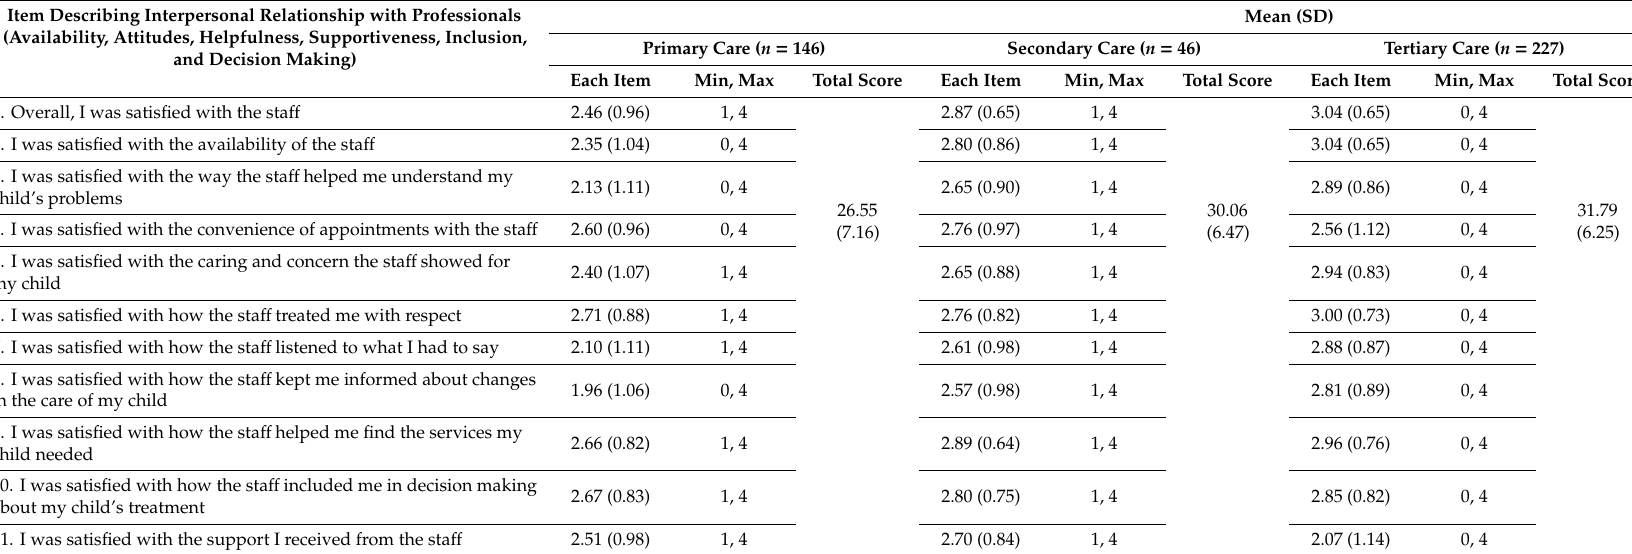
Table 3. Summary of the mean scores of satisfaction among caregivers of children with ASD at di ff erent health care facilities in